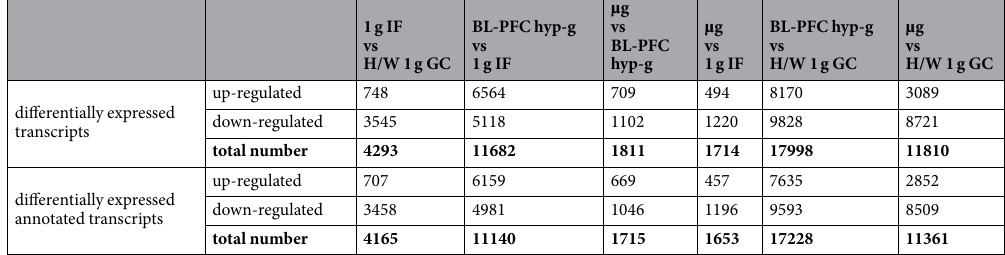
Table 2. Numbers of differentially expressed transcripts in comparisons of the experiment groups of the 19 th DLR parabolic flight campaign. Differential expression is defined as t-test p-value < 0.05; fold change ≤− 1.3 or ≥ + 1.3. The term “transcripts” refers to all 45034 transcripts of the array, whereas “annotated transcripts” refers to the 42947 transcripts that are annotated to a gene.